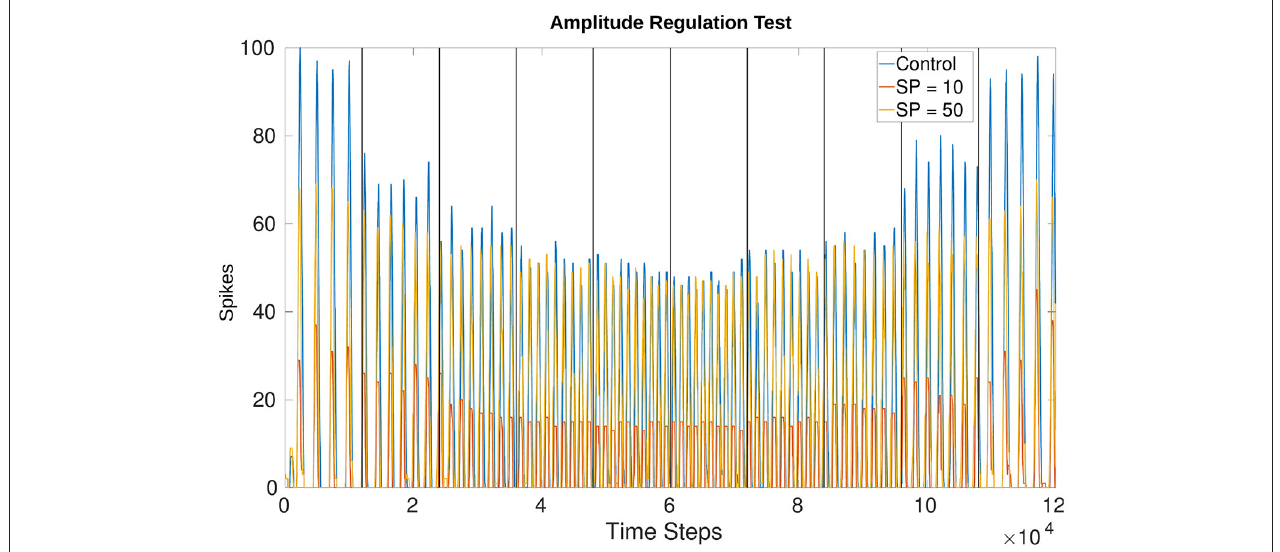
FIGURE 11 | Comparison of amplitude when running the network unregulated vs. creating a set point (SP) at 10 spikes and 50 spikes. The SP in this plot is equivalent to the “desired spike value” referred to in Equation (8). There is more overshoot for lower frequencies as compared to higher frequencies but the change in amplitude is visible from the control experiment where w max is applied uniformly. Vertical lines indicate when a change in voltage threshold potential occurs thereby changing the frequency. The threshold updates every 1,200 time steps (1.2 s ) creating a total of 10 divisions. V th starts at − 54.81 mV producing a frequency of 3.77 Hz and increases to − 50.79 mV producing a frequency of 9.14 Hz . After 6,000 time steps V th decreases again, returning to a value of − 54.74 mV producing a final frequency of 4.00 Hz . The middle two trials from 4,800 to 7,200 time steps are held at the highest V th , around − 50.79 mV . The values fluctuate by hundredths of a mV because V th is affected by current noise.